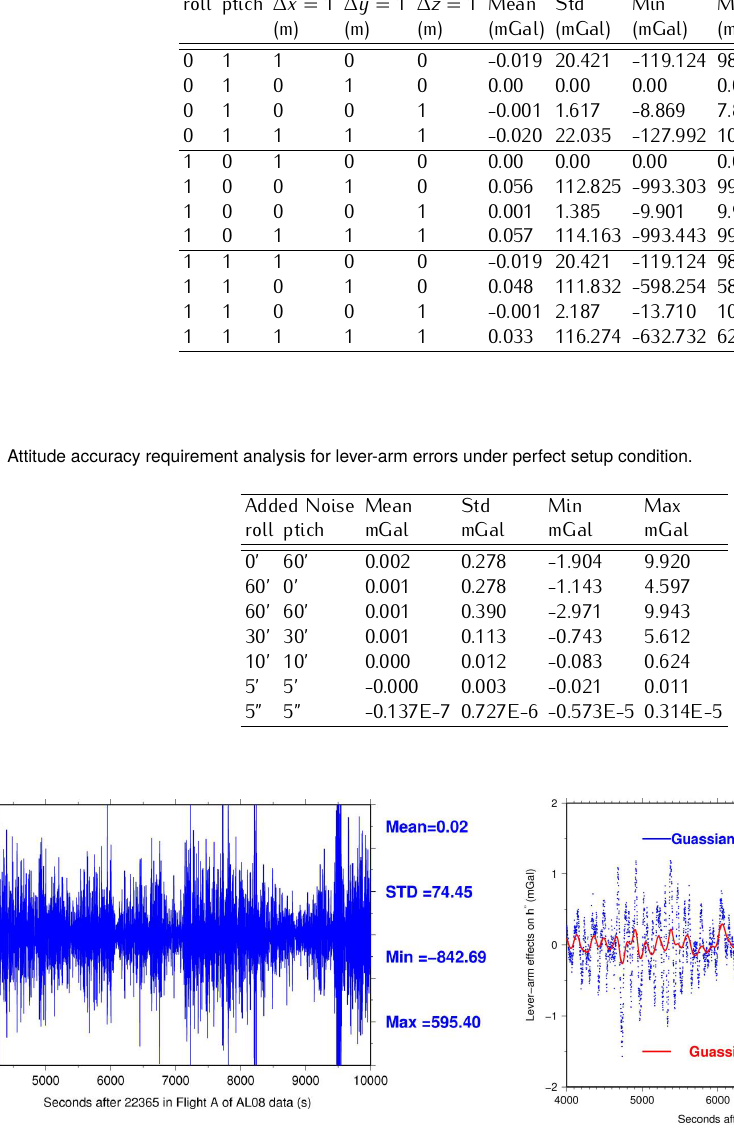
Figure 10. The lever-arm errors along the track of Flight A.